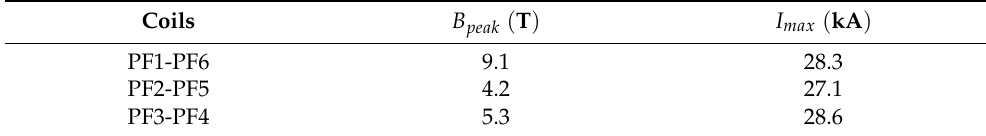
Table 1. Maximum currents and magnetic fields for PF coils.